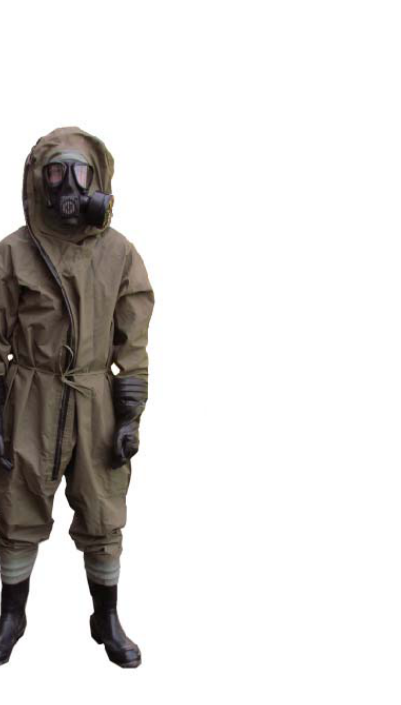
Figure 5 – M5 protective suit in use in the SAF CBRN units Рис . 5 – Защитный костюм М 5, используемый войсками РХБЗ ВСРС Слика 5 – Заштитни комбинезон М 5 на употреби у јединицама АБХ службе ВС According to the product quality regulation (Vojnotehni č ki institut, 1985), the manufacturer defined the following characteristics of the KZ-